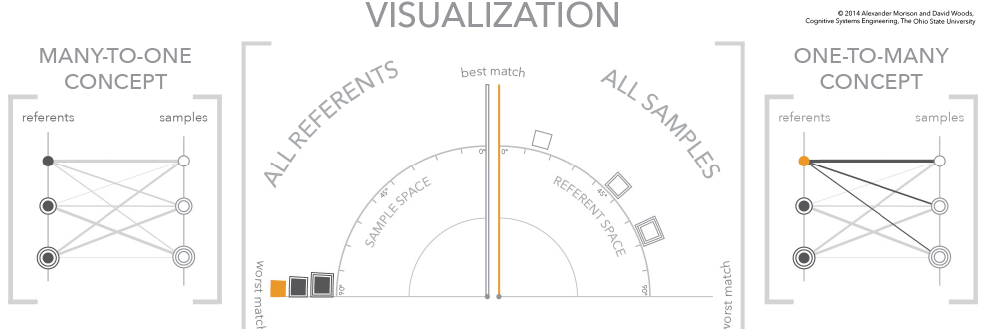
Figure 6. The second figure in a three-figure sequence showing the dynamics of the visualization. A